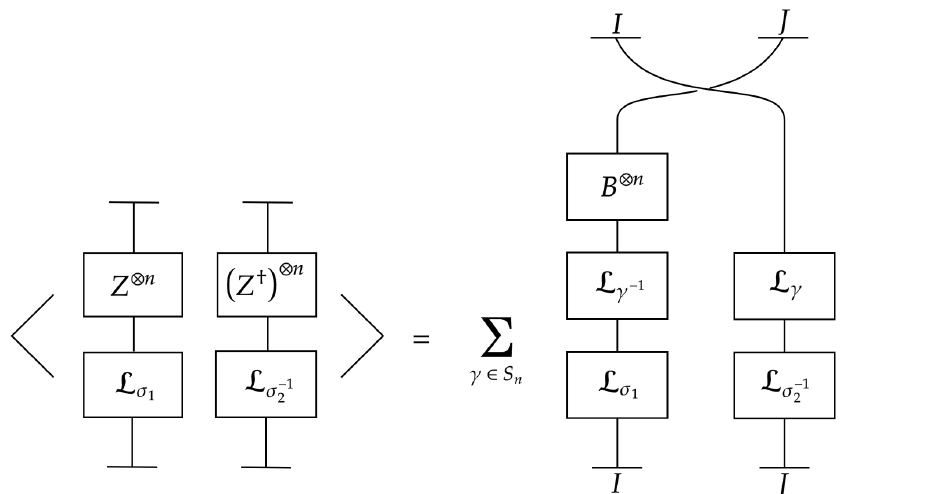
Figure 8 . The correlator diagrams where each box is an operator connected by branches. The right side diagram explicitly shows the indices, indicating that horizontal lines are to be thought of as traces connecting the bottom and top. The diagram is read by following branches downward and multiplying the operators